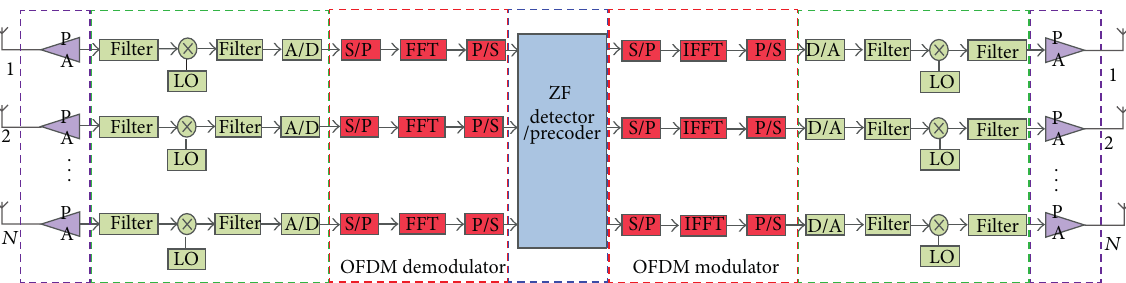
Figure 2: Components of power consumption at the relay